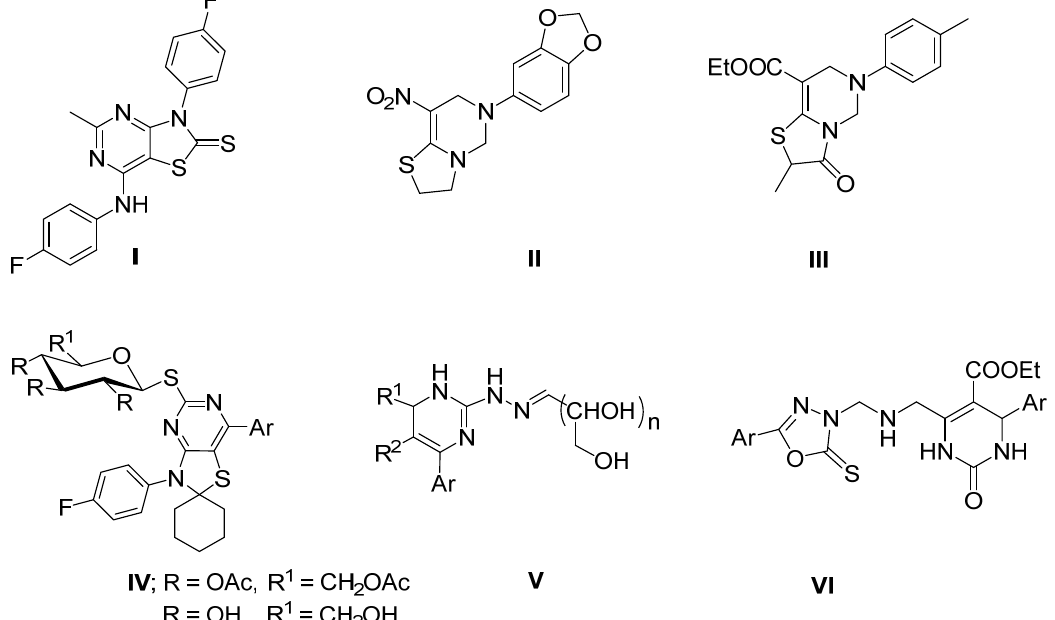
Figure 1. Anticancer thiazolopyrimidine, pyrinidinyl-sugar, and pyrimidinyl-oxadiazole compounds. 2. Results and